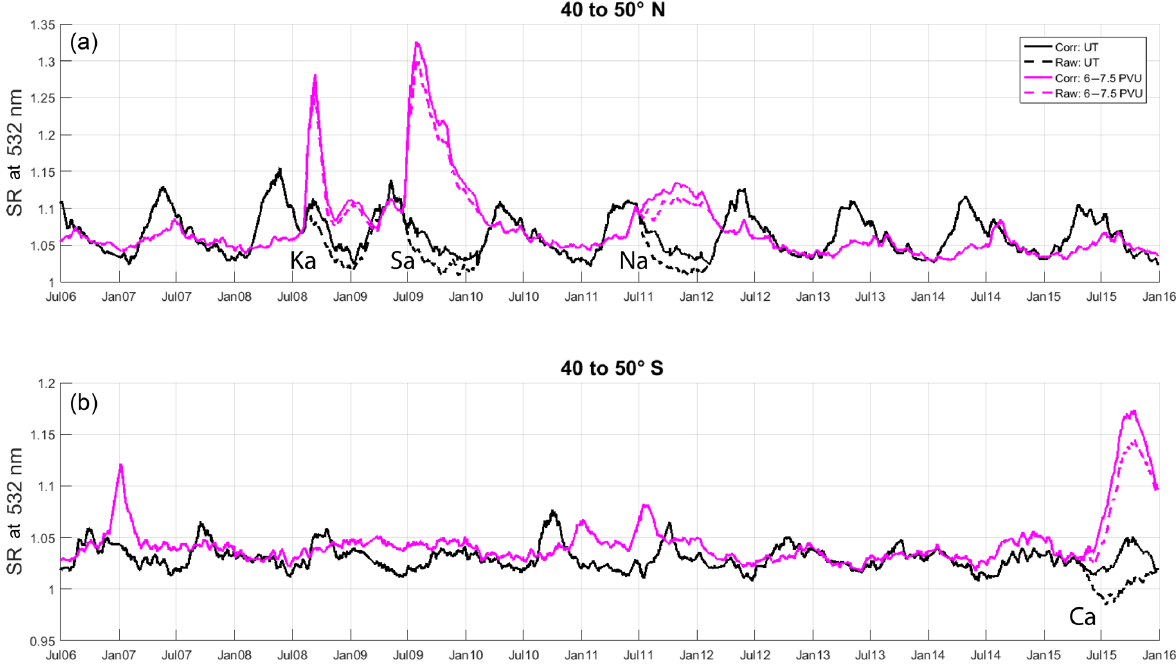
Figure 2. Examples illustrating the effects from corrections made to compensate for the laser attenuation caused by aerosol particles. The scattering ratios (SR) were averaged over the latitude intervals (a) 40–50 ◦ N and (b) 40–50 ◦ S for the UT (black; 250–1000m below the tropopause) and the PV layer of 6–7.5PVU (magenta). Volcanic eruptions are indicated by their abbreviations. Both layers are on average